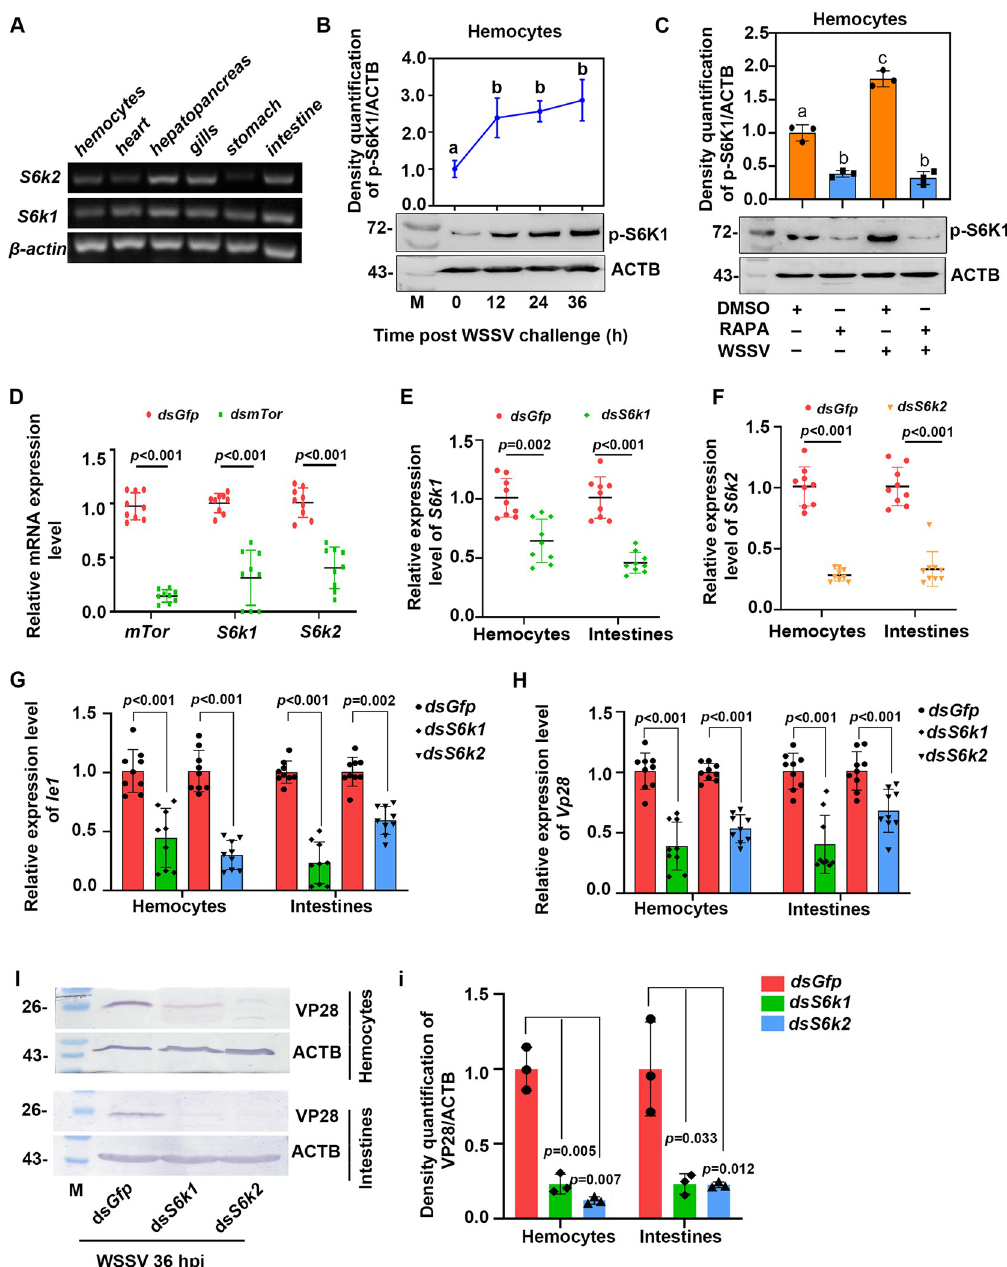
Fig 3. WSSV replication was suppressed in shrimp after a knockdown of downstream targets of mTORC1, S6k1 and dsS6k2 , following WSSV infection. ( A ) Tissue distribution of S6k1 and S6k2 in shrimp at the mRNA level detected using RT-PCR. ( B ) The phosphorylation of S6K1 at different time points in the hemocytes of shrimp challenged with WSSV analyzed by Western blot. The upper panel represents the statistical analysis of three independent experiments of the lower panel. ( C ) Changes in the level of S6K1 phosphorylation in hemocyes of shrimp following treatment with rapamycin and WSSV infection. In panel B and C, the subpanels of p-S6K1 and ACTB were from different gels with same amount of loading samples. ( D ) The mRNA expression level of S6k1 and S6k2 in the mTor -RNAi shrimp. ( E and F ) Efficiency of S6k1- (E) and S6k2- RNAi (F) in the hemocytes and intestines of shrimp as detected by qPCR. ( G and H ) The level of Ie1 (G) and Vp28 (H) mRNA expression in the hemocytes and intestines of shrimp following S6k1 or S6k2 interference. ( I ) The level of VP28 expression in the hemocytes and intestines following a knockdown of S6k1 or S6k2 . ( i ) Statistical analysis of three independent experiments for VP28 expression in shrimp. An injection with dsGfp was used as a control. The mRNA and protein used for WSSV replication analysis were extracted from hemocytes and intestines of the shrimp infected with WSSV at 36 hpi. Significant differences were analyzed using a Student’s t -test and significant differences were accepted at P < 0.05; different lowercase letters indicate significant differences ( P < 0.05) in the one-way ANOVA